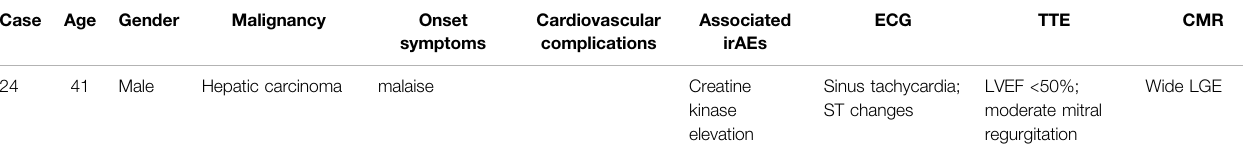
Frontiers in Pharmacology |